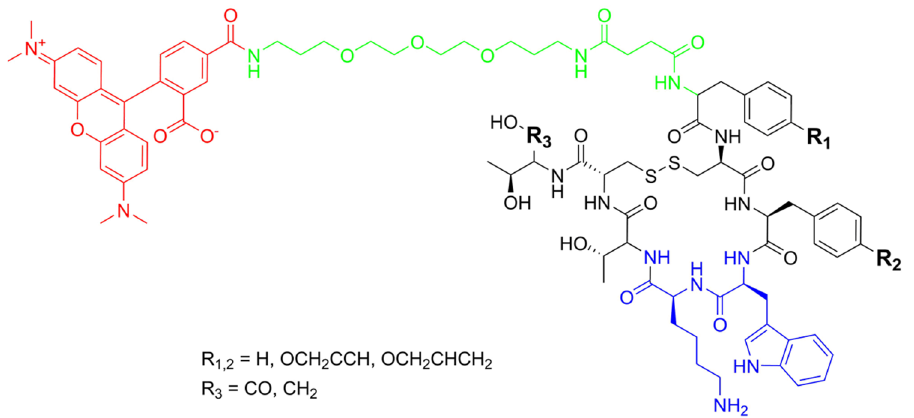
Figure 5. General structure of the peptides marked with TAMRA (red) conjugated by a linker structure (green). The linker was attached to the N terminus of the peptides to prevent possible interference of TAMRA with the main binding motif of the peptides (blue).